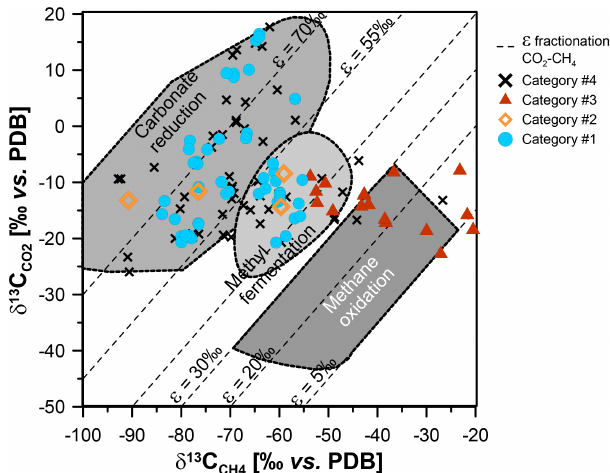
Figure 11. δ 13 C values of methane and CO 2 revealing methane for- mation and consumption pathways, confirming that category no. 3 samples plot near the methane oxidation field adapted from Whiticar